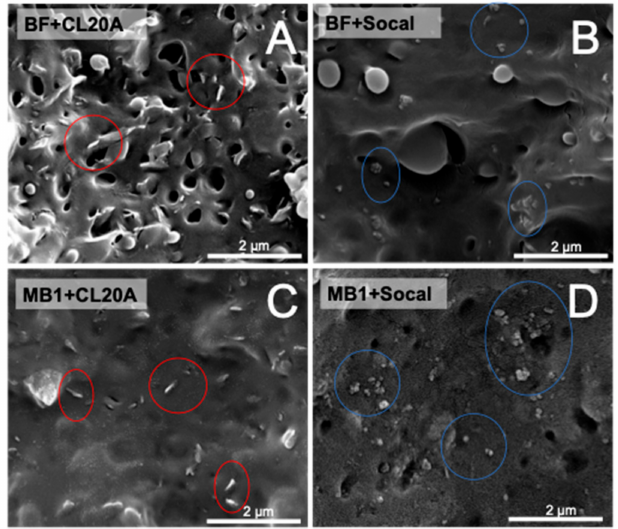
Figure 4. Typical SEM micrographs of bionanocomposites based on Bioflex F2110 (BF, ( A , B )) and MaterBi ® EF05B (MB1, ( C , D